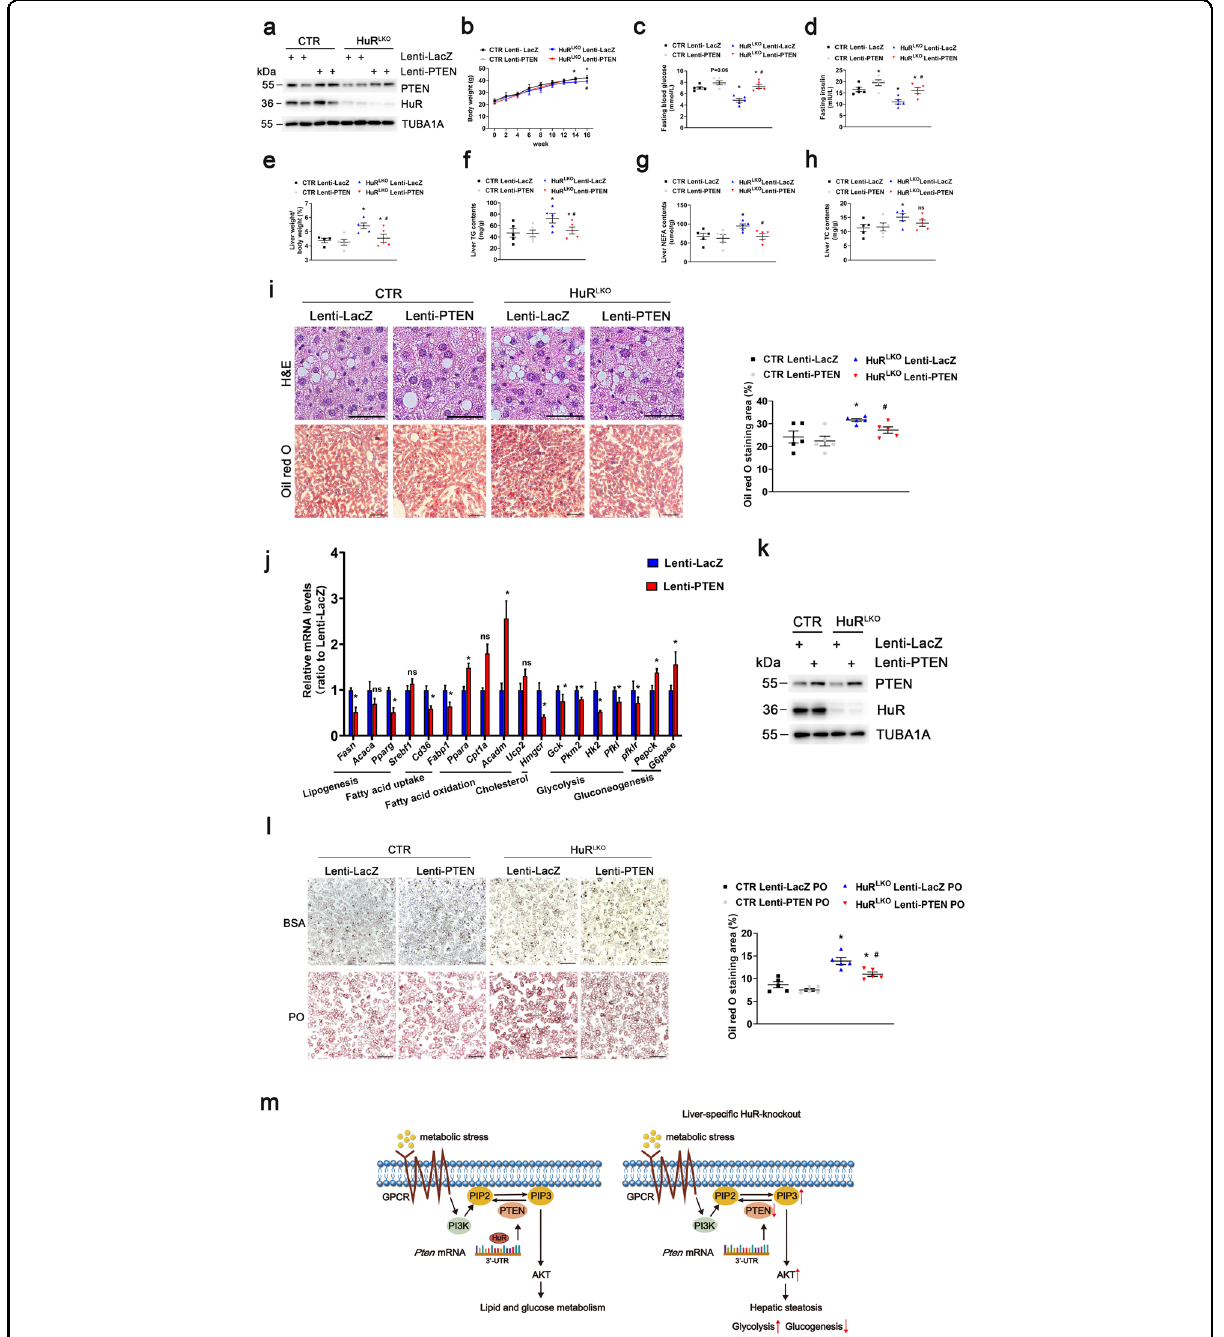
Fig. 6 HuR regulates hepatocyte steatosis through PTEN. a HuR LKO and CTR mice were injected with LacZ or PTEN lentivirus (1.0E + 07TU per mice) and fed a HFD. Western blot analysis of PTEN protein levels. b Body weight of mice in different groups ( n = 5). * P < 0.05 vs CTR Lenti-LacZ, # P < 0.05 vs HuR LKO Lenti-LacZ. c Fasting glucose levels in the liver of mice ( n = 5). * P < 0.05 vs CTR Lenti-LacZ, # P < 0.05 vs HuR LKO Lenti-LacZ. d Fasting insulin levels in the liver of mice ( n = 5). * P < 0.05 vs CTR Lenti-LacZ, # P <0.05 vs HuR LKO Lenti-LacZ. e Liver weight to body weight ratio of mice ( n = 5). * P < 0.05 vs CTR Lenti-LacZ, # P < 0.05 vs HuR LKO Lenti-LacZ. TG ( f ), NEFA ( g ), and TC ( h ) levels in the liver of mice ( n = 5). * P <0.05 vs CTR Lenti - LacZ, # P <0.05 vs HuR LKO Lenti-LacZ. i H&E-stained (top) and Oil-red O-stained (bottom) liver sections from mice. Scale bar, 50 μ m. Quantitative analysis (right) of the mean Oil-red O-stained area ( n = 5). * P <0.05 vs CTR Lenti-LacZ, # P < 0.05 vs HuR LKO Lenti-LacZ. j Relative mRNA levels of the indicated molecules in the livers of mice ( n = 5). * P < 0.05 vs HuR LKO Lenti-LacZ. k Western blot analysis of PTEN protein levels. l CTR and HuR LKO mice primary hepatocytes infected with PTEN lentivirus were treated with BSA or PO for 24h, followed by Oil-red O staining ( n = 3). Scale bar, 100 μ m. * P < 0.05 vs CTR Lenti-LacZ PO, # P < 0.05 vs HuR LKO Lenti-LacZ PO. m Schematic diagram of the mechanism of HuR in lipid and glucose metabolism.